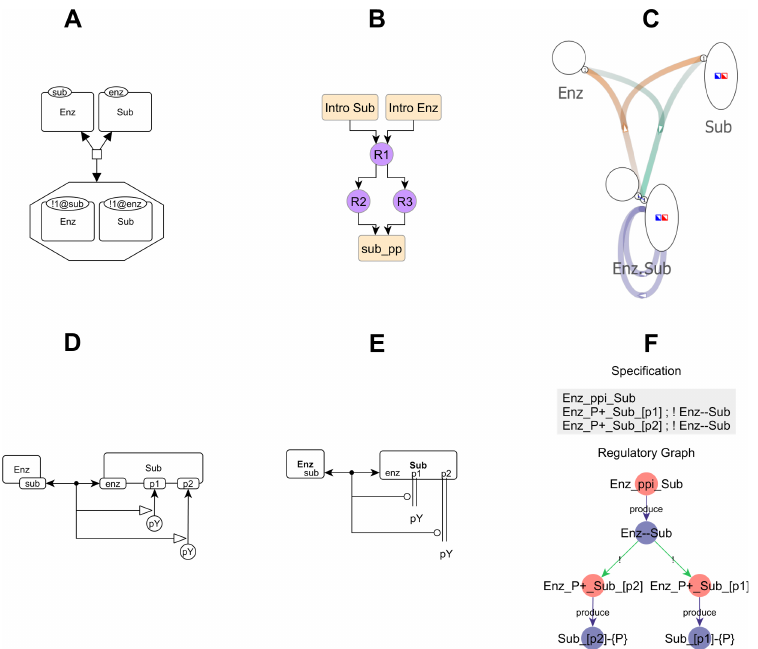
Fig 11. Other visualization approaches applied to the enzyme-substrate phosphorylation model of Fig 2. (A) The bindingrule drawn using SBGN Process Descriptionconventions, which require visual graph comparison. (B) Kappa story, showingthe causal order of rules that produces sub_pp,which refers to doubly phosphorylated substrate. (C) Simmune Network Viewer diagram, which merges patterns across rules and hides certain causal dependencies(details in S4 Fig). Here, the Enz.Sub nodemerges all enzyme-substrate patterns shown in Fig 2. (D) SBGN Entity Relationship. (E) MolecularInteraction Map. Panels D-E require manualinterpretation of the model, like the extendedcontact map. (F) rxncon regulatory graph visualizationof the rxncon model format, which can only depict a limited subset of reactionrules (details in S5 Fig).